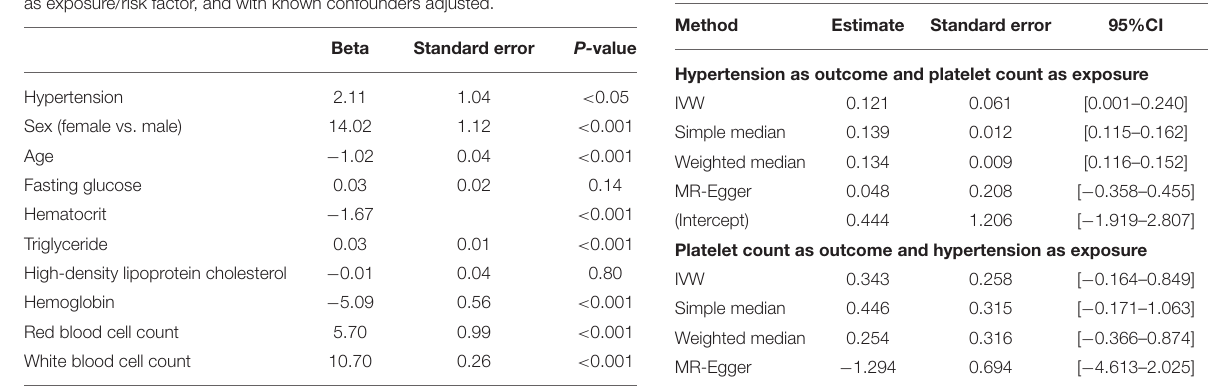
TABLE 5 | Bi-directional causality of platelet count and